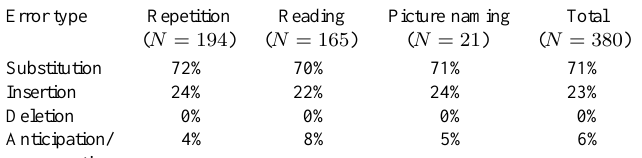
Table 4 Distribution of various subtypes of onset errors in oral production